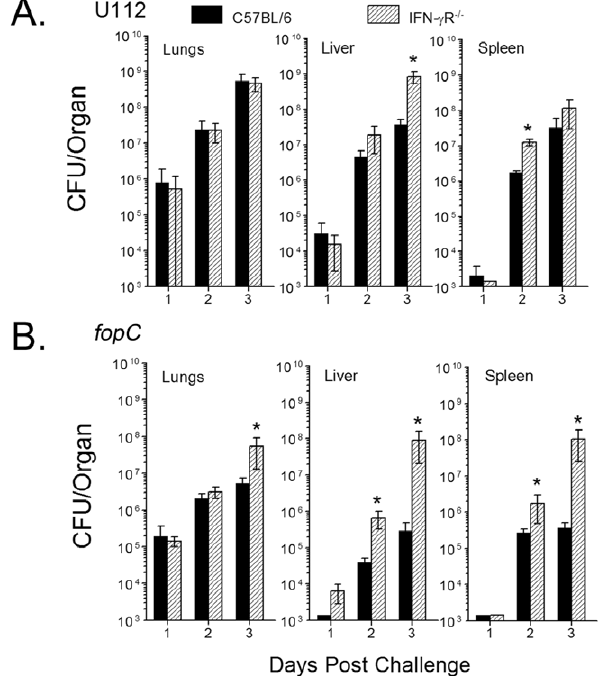
Figure 4. Dissemination of U112 and fopC mutant in C57BL/6 and IFN- c R 2 / 2 mice. Mice were challenged i.n. with 10 3 CFU wildtype U112 (A) or fopC mutant (B). Organs (lungs, liver and spleen) were collected on days 1, 2, and 3 postchallenge (n=3 at each time point), homogenized, and dilution plated for bacterial enumeration. Results are log 10 CFU per organ (lower detection limit was approximately 1000 CFU/organ). Differences between replication of U112 and fopC strains are significant with p values , 0.05 represented by * in the figure. (Representative of two experiments.)